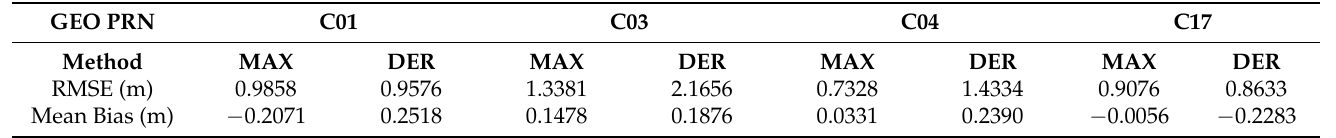
Figure 11. Scatter plot of the SSH results obtained using the above-mentioned GNSS-R ocean altimetry method for BDS GEO signals. Table 2. Altimetry precision obtained using BDS GEO for different types of characteristic